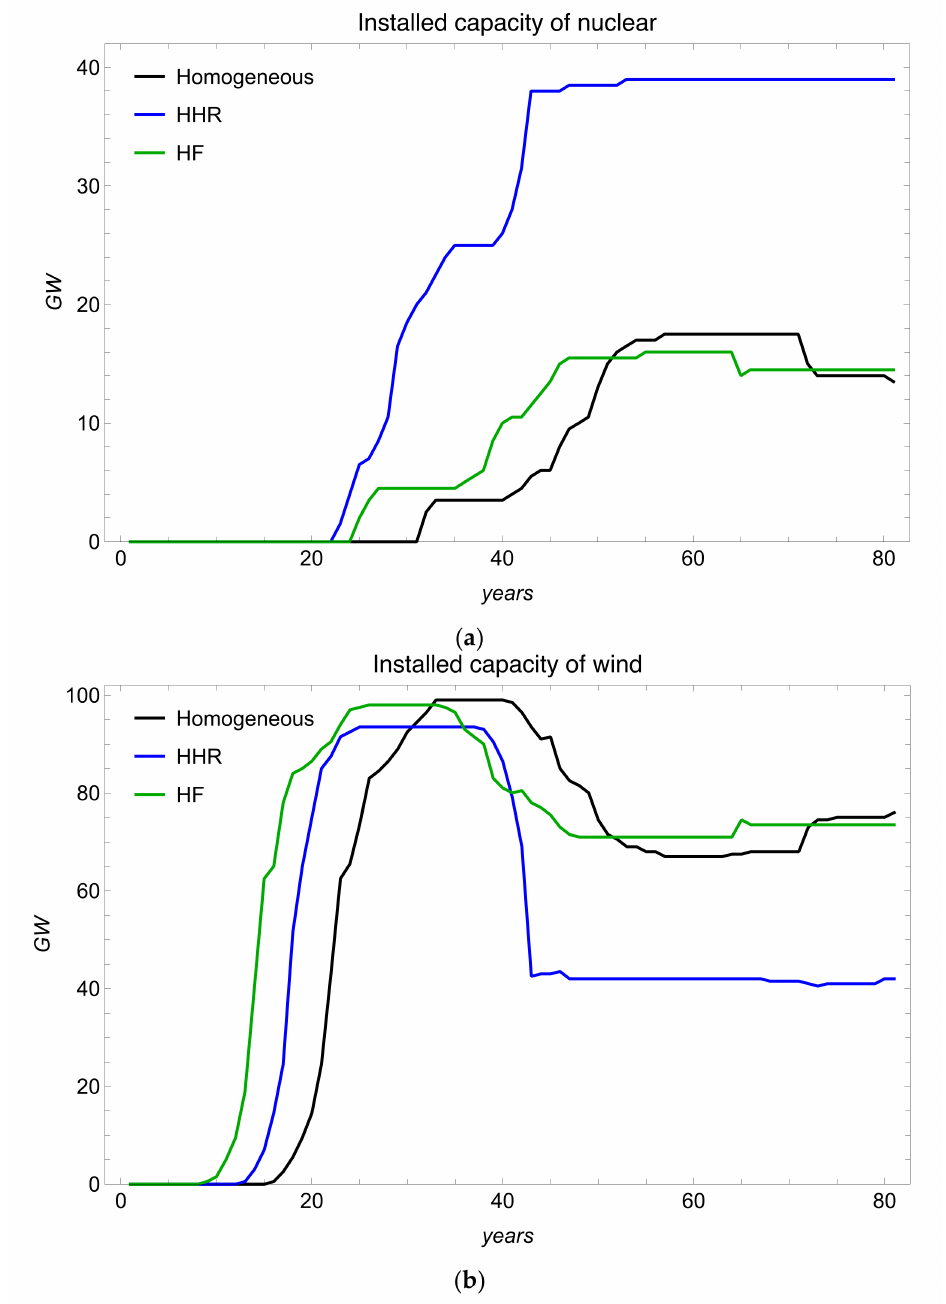
Figure 2. Installed capacity by technology in homogeneous, HHR, and HF cases. ( a ) Nuclear, ( b ) wind. In the HHR case, there is significantly more nuclear and less wind. The earliest wind expansion is observed in the HF